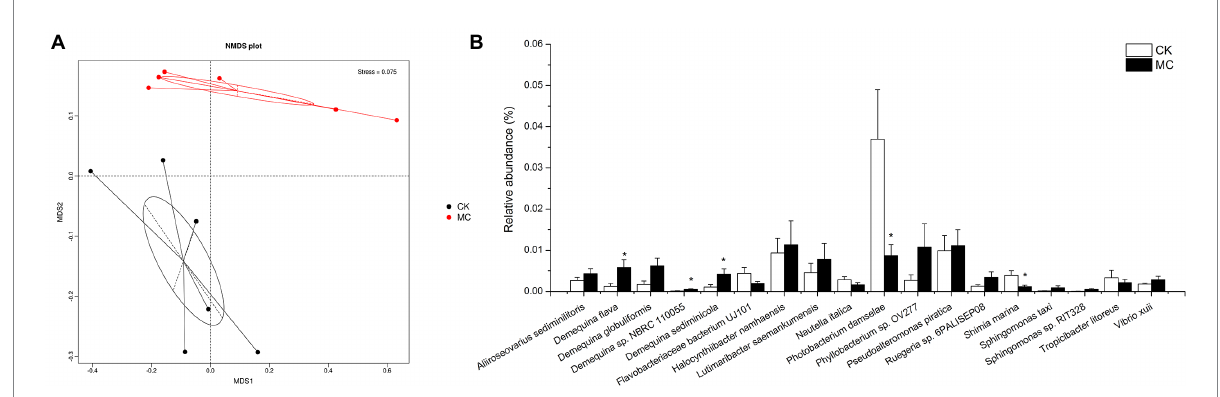
FIGURE 3 Comparison of intestinal bacteria species of L. vannamei after MC-LR exposure. (A) NMDS analysis. (B) The relative abundance of bacteria species. * Indicates significant differences between the two groups ( p <